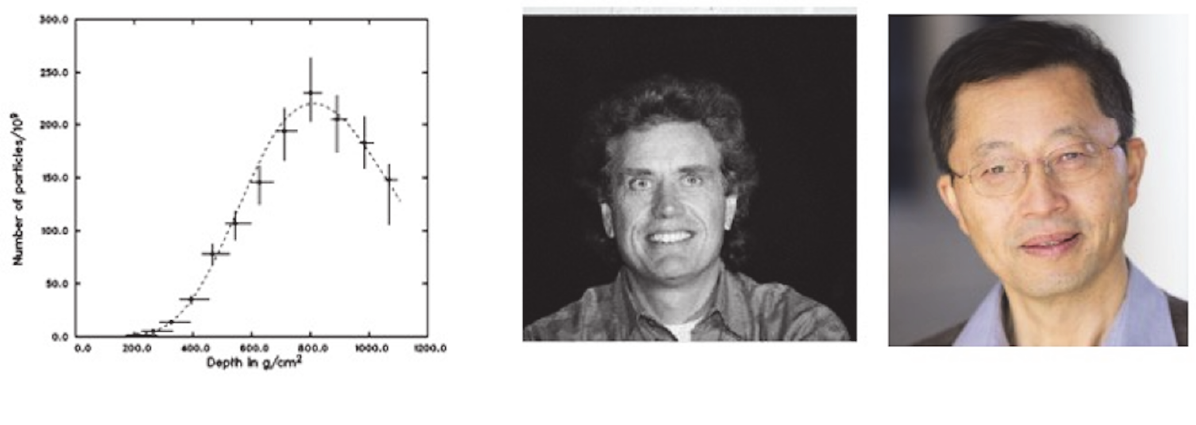
Figure 6. “Oh My God Particle” profile (L), P. Sommers and H.